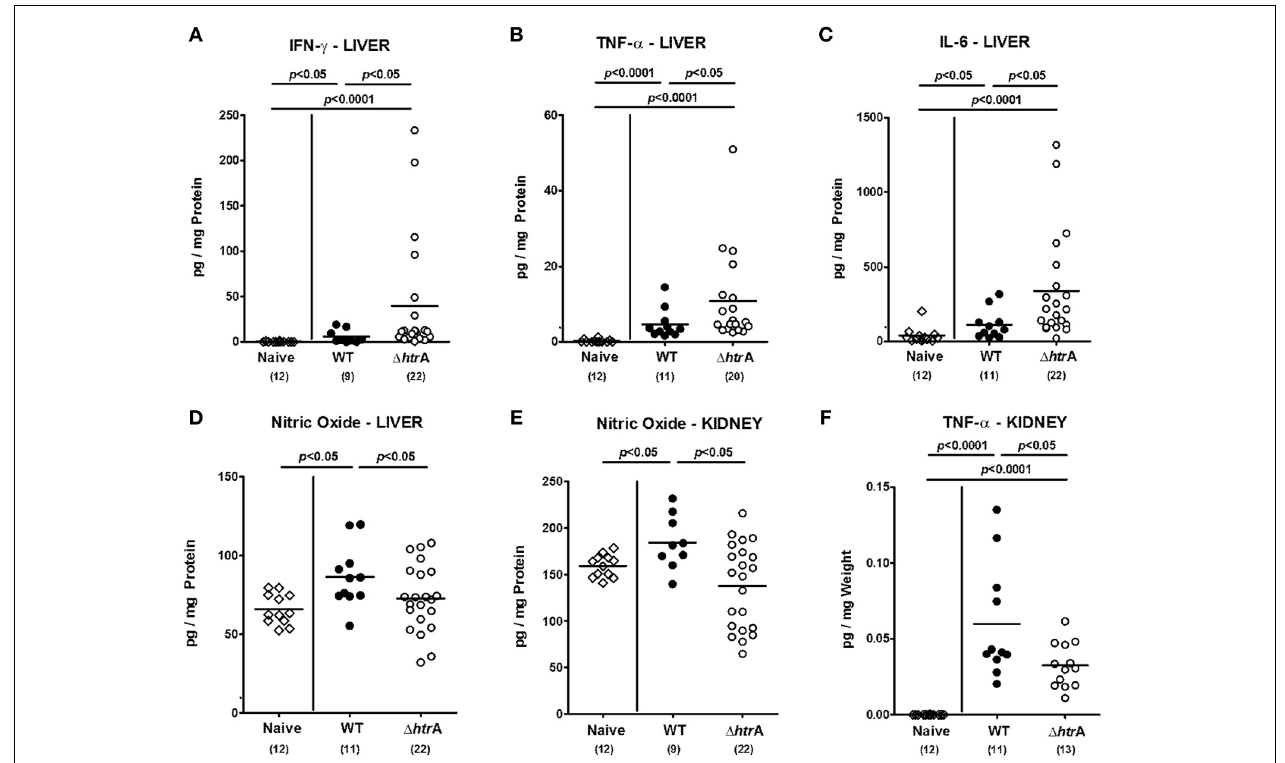
(F) TNF- α levels were determined in supernatants of ex vivo biopsies taken at day 6 p.i. Data shown were pooled from at least three independent